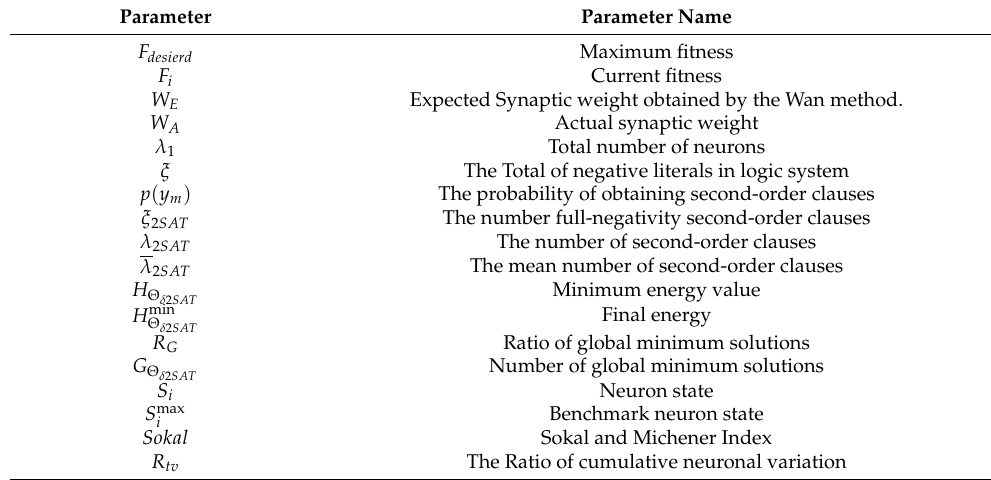
Table 4. List of parameters used in DHNN − δ 2 SAT experimental